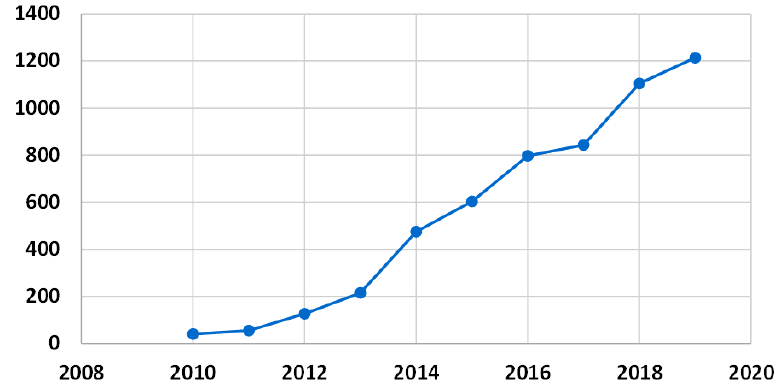
Figure 5. Big data papers published per year as indexed on Scopus and Web of Science from 2010 – 2019.